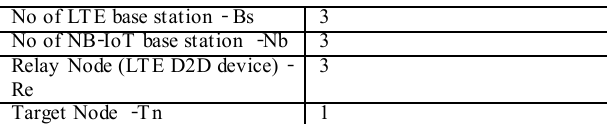
Table 2: Simulation environment No of LTE base station - Bs 3 No of NB-IoT base station